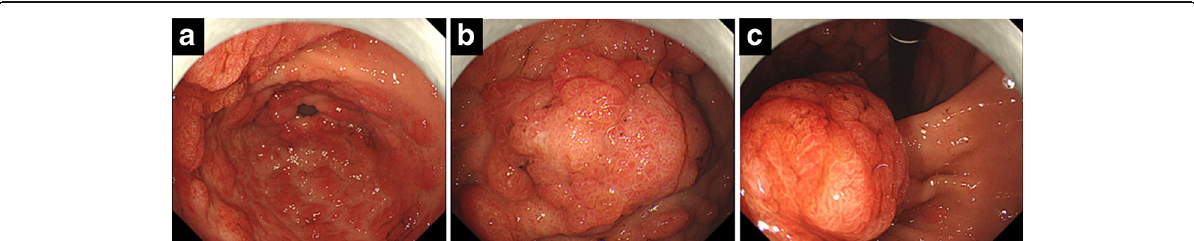
Fig. 1 Endoscopic appearance of multiple reddish polyps accompanied by bleeding and erosion throughout the stomach ( a ). Elevated lesions with irregular margins in the anterior wall of the corpus ( b ) and lesser curvature of the angular region ( c ) of the stomach. Biopsy of the elevated lesions revealed them to be well-differentiated adenocarcinomas